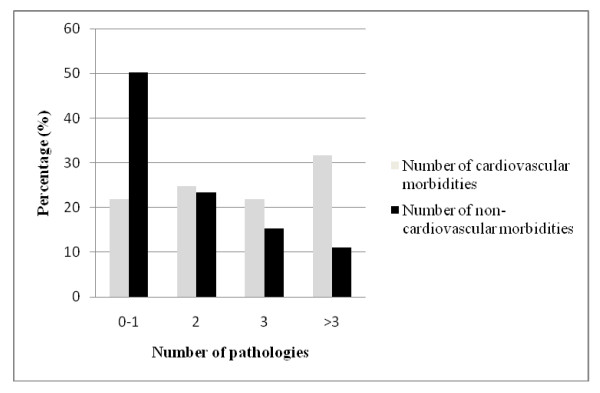
Number of comorbidities.